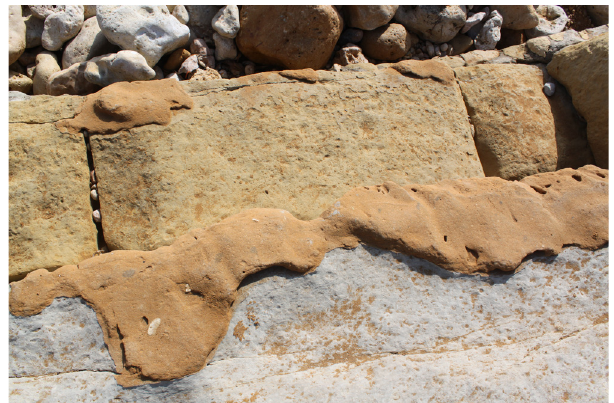
Figure 8: Detail of red hardened clay binding the stone and fi lling some interstices of the newly discovered ashlar blocks ( Source: Author )